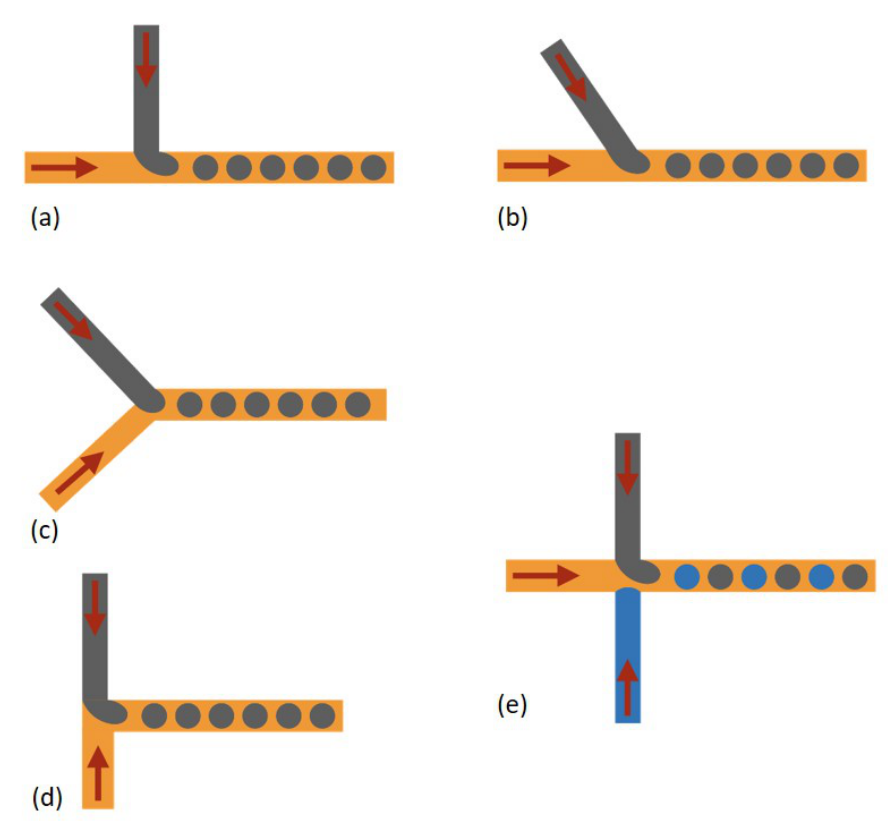
Figure 1. Cross-flow for droplet generation. ( a ) T-junction. ( b ) and ( c ) Y-junction. ( d ) Head-on junction. ( e ) Alternating T-junction.